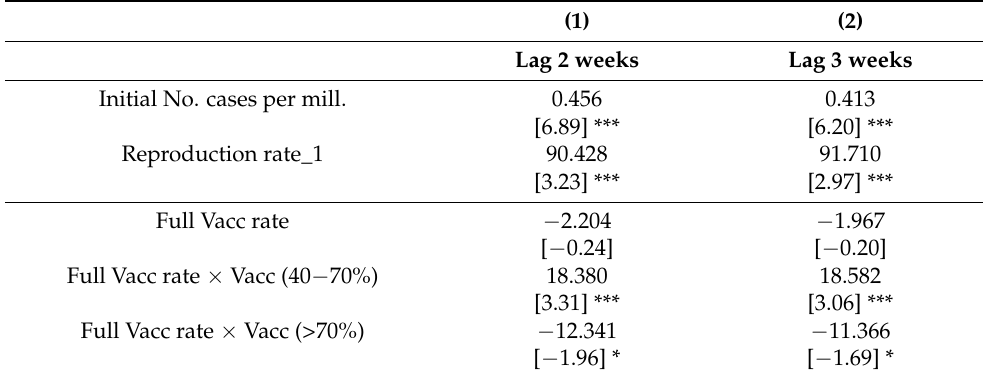
Table A8. Impact of vaccination rate on number of new COVID cases in 2021 compared to 2020, all